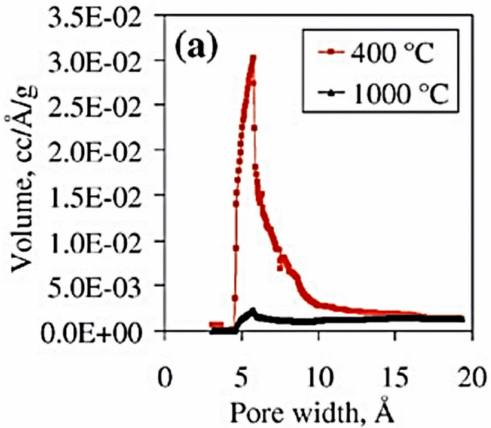
Figure 14. Pore size distribution of the micropores formed on a 25 nm film of MLD alucone after oxidation at 400 ◦ C and 1000 ◦ C in air. The substrate was SiO 2 particles. Reprinted with permission from [109], Royal Society of Chemistry,